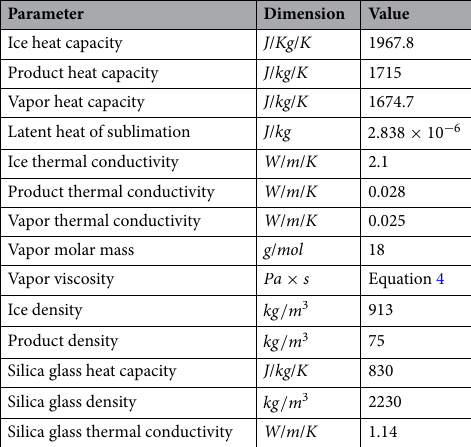
Table 2. Fixed simulation parameters.